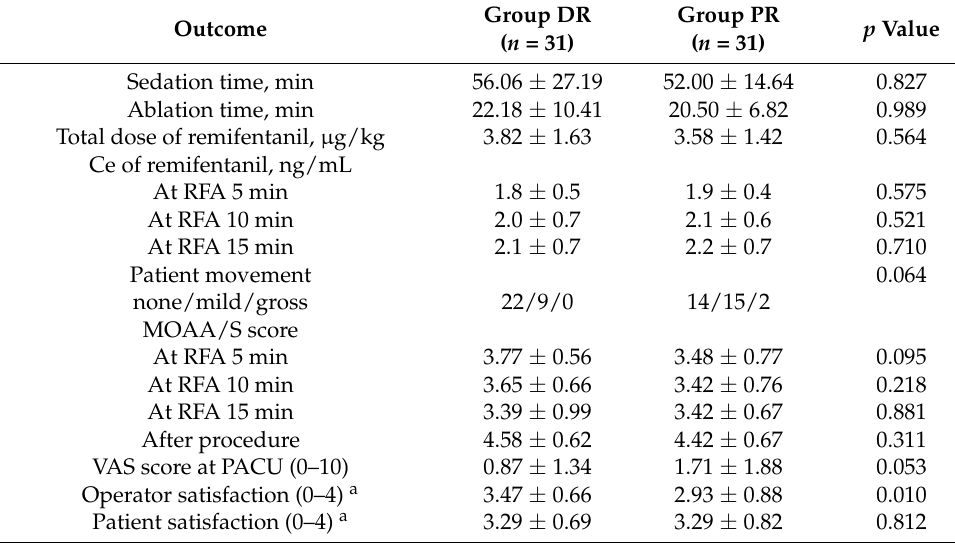
Table 2. Sedation and RFA related